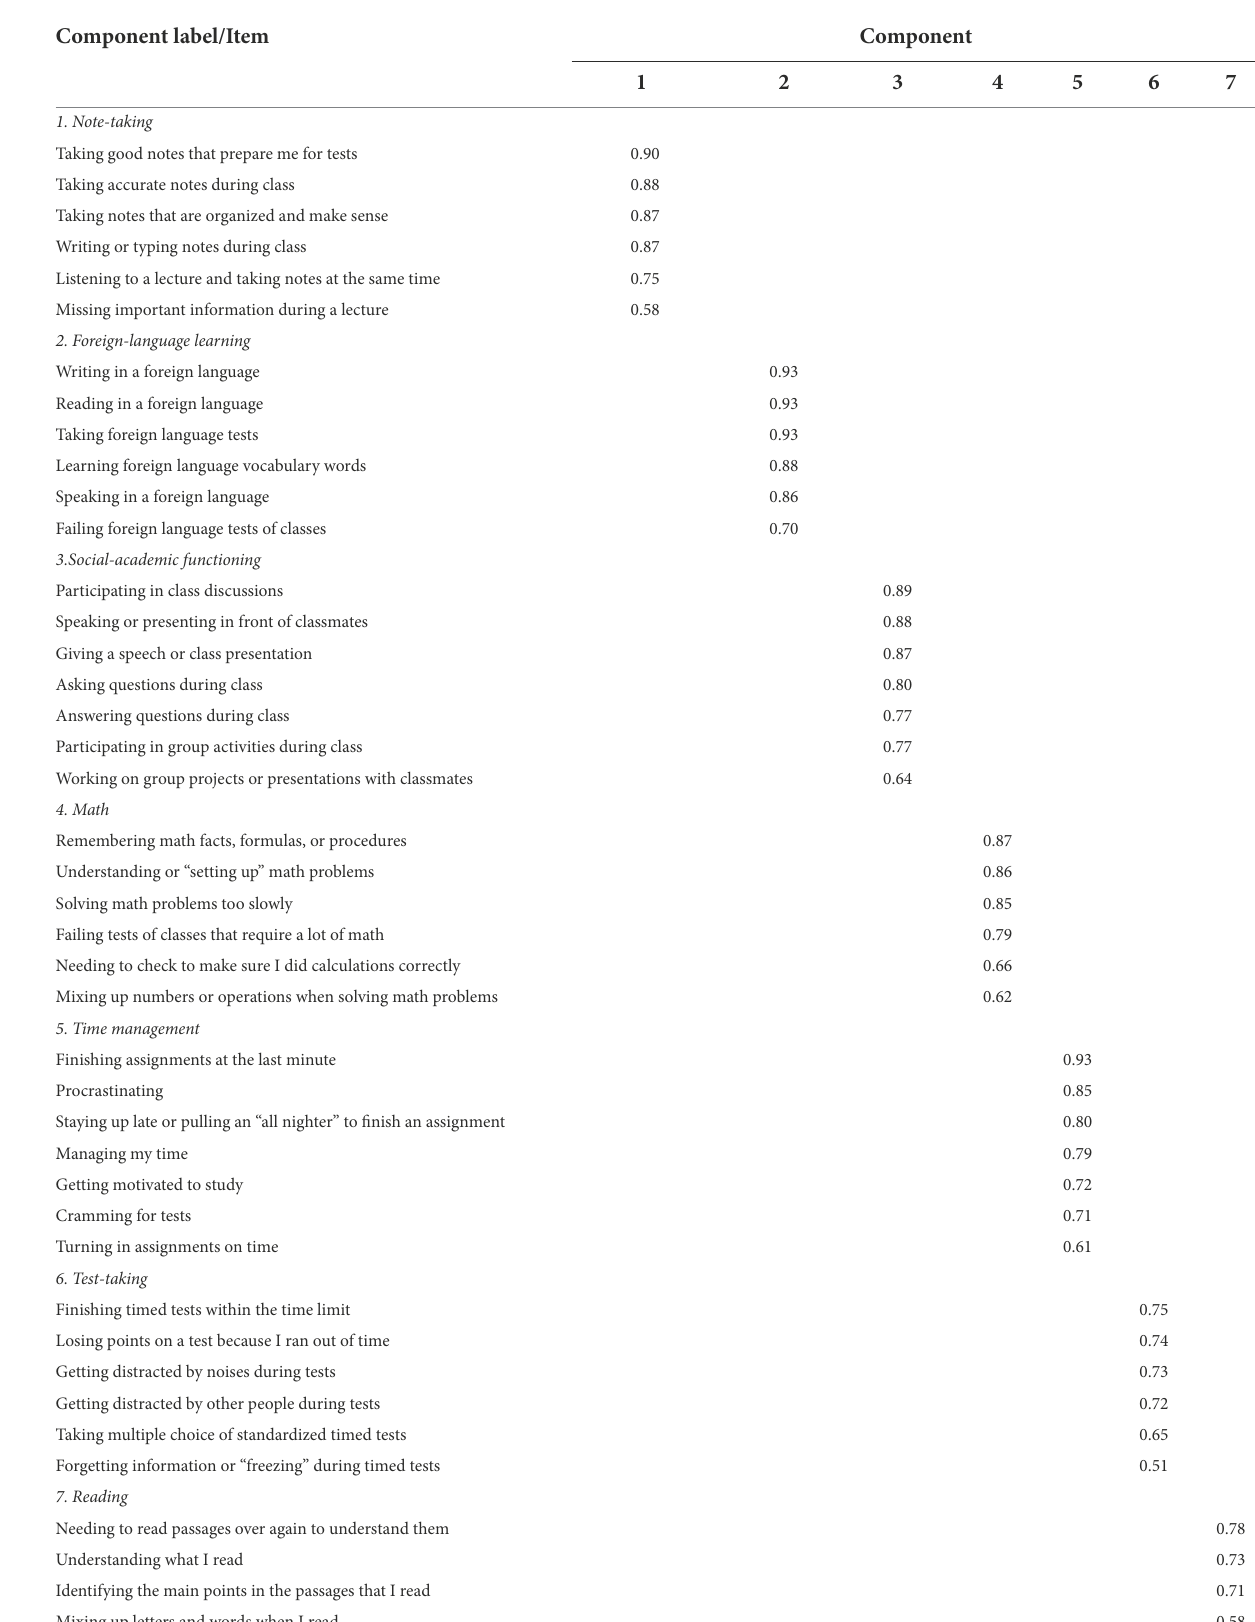
TABLE 2 Results of the principal component